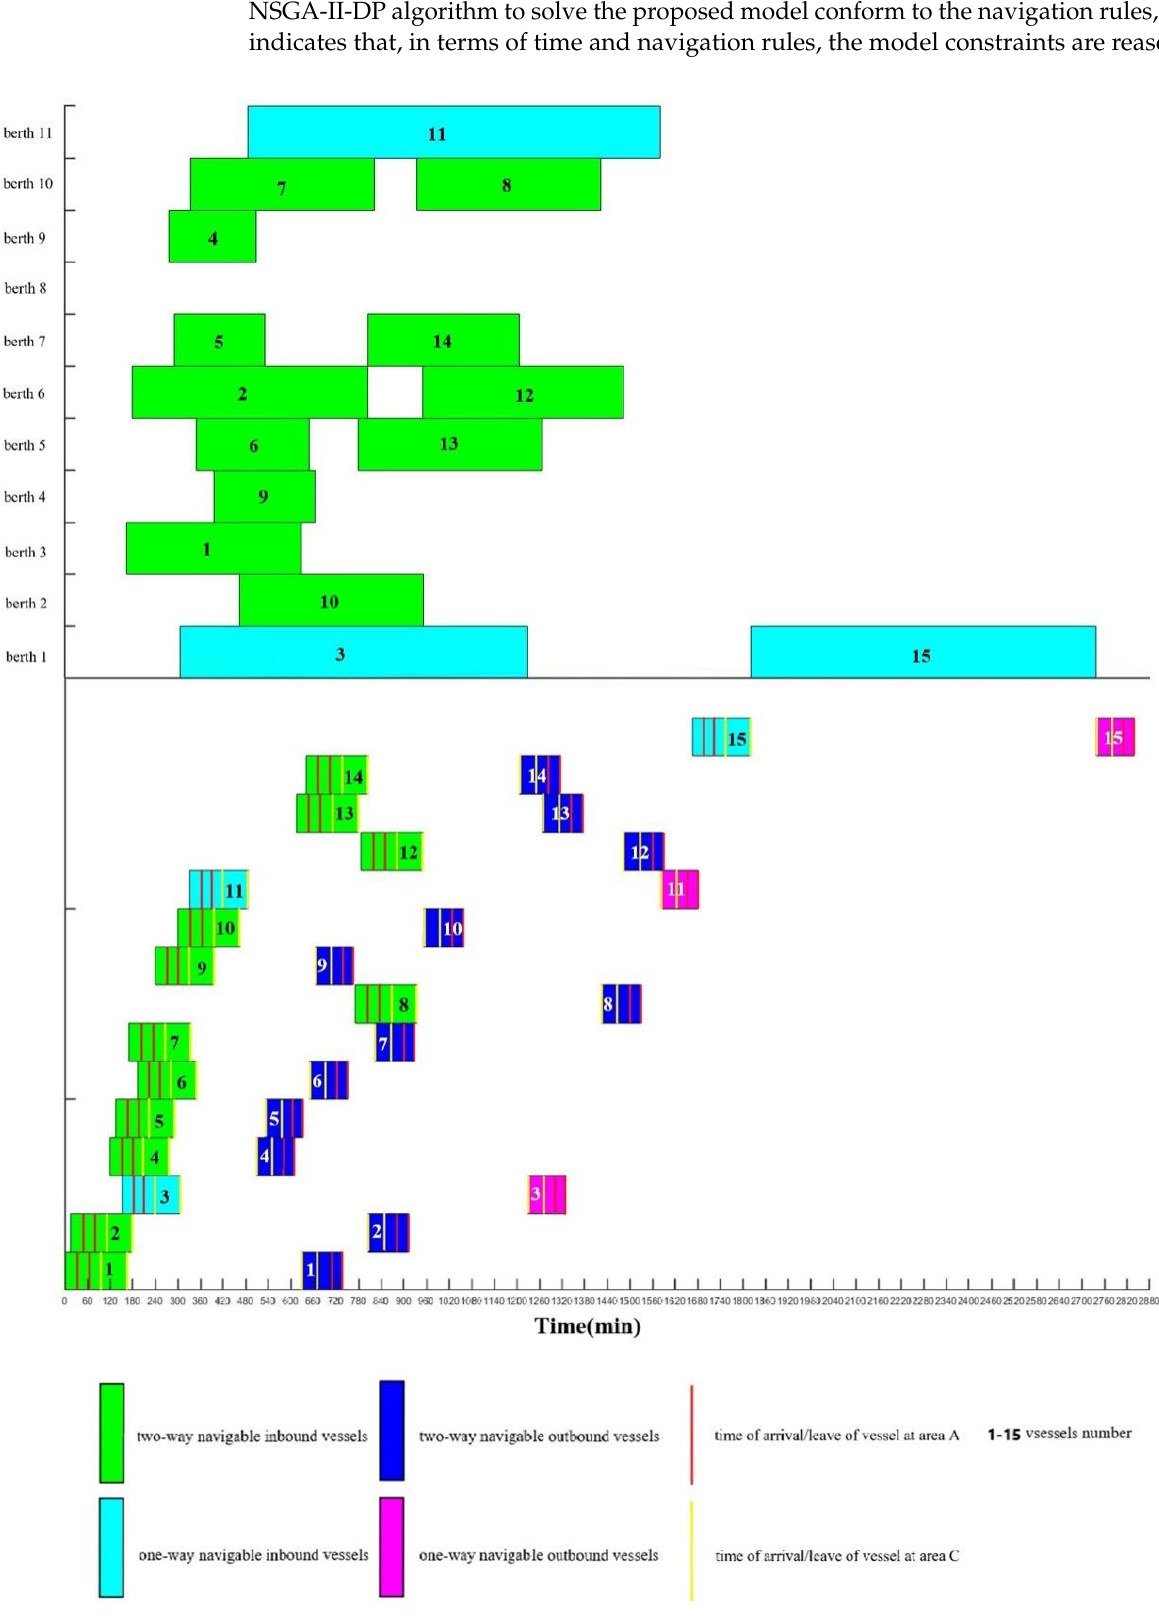
Figure 10. Gantt chart of the navigation channel and berths.